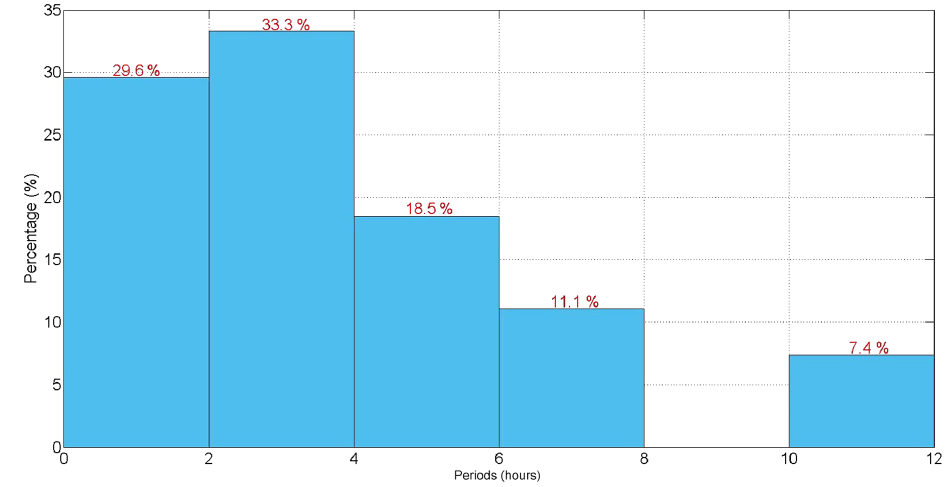
Figure 7. Histogram with the periods of highest correlations between IMF B z component and B x geomagnetic